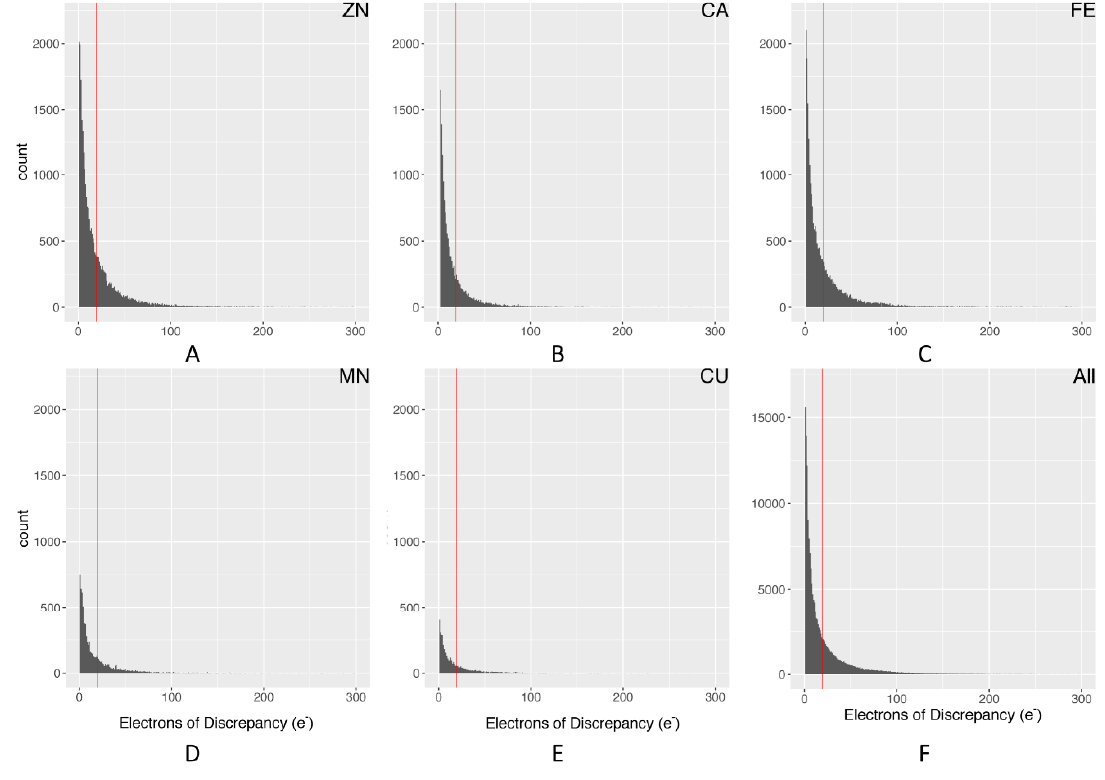
Figure 3. Distribution of electron discrepancy within 3.5 Å of the metal ion: ( A ) Zn; ( B ) Ca; ( C ) Fe; ( D ) Mn; ( E ) Cu; ( F ) all metal ions. The red line represents a standard deviation cutoff of 1, calculated from the distribution in graph F with outliers removed.